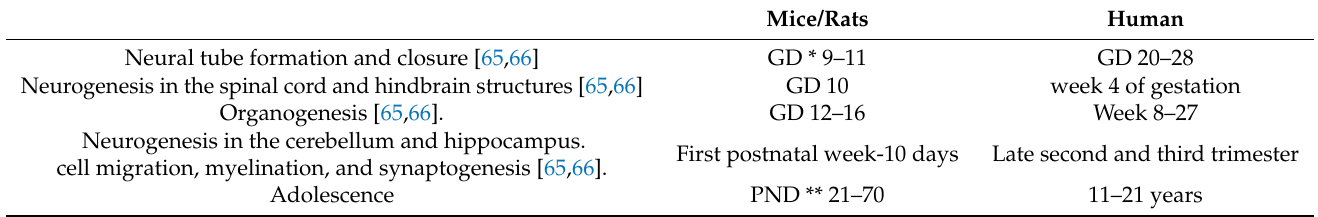
Table 2. Timing differences in brain development in mice and rats compared to human. Mice/Rats Human Neural tube formation and closure [65,66] GD * 9–11 GD 20–28 Neurogenesis in the spinal cord and hindbrain structures [65,66] GD 10 week 4 of gestation Organogenesis